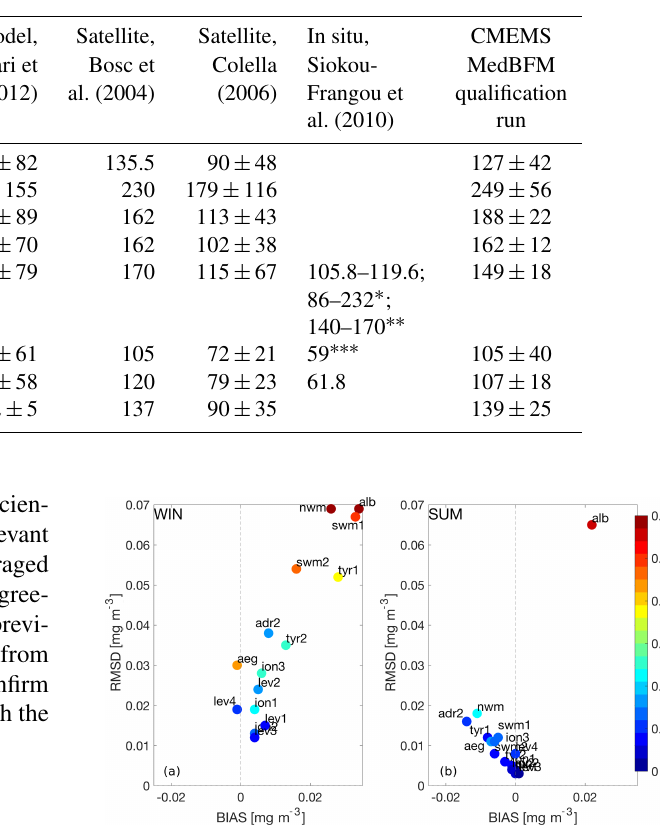
Table 2. Annual averages and short period estimates of the vertically integrated primary production for some selected sub-regions. Estimates are from multi-annual simulation (Lazzari et al., 2012), from satellite model (Bosc et al., 2004; Colella, 2006), from in situ estimates (Siokou- Frangou et al., 2010) and from the present CMEMS qualification run. Notes: ∗ only DYFAMED station; ∗∗ southern Gulf of Lions; ∗∗∗ only Cretan Sea.